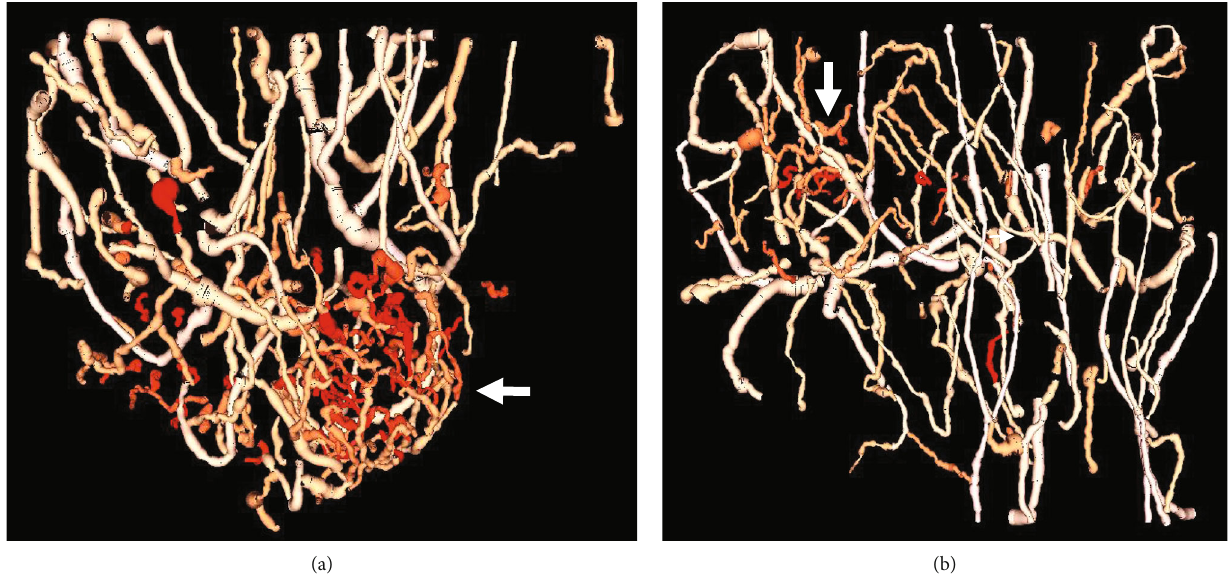
Figure 7: Renderings of segmented vasculature of tumors with color intensity showing tortuosity (SOAM). (a) shows a large tumor (5.1 mm) and (b) shows a smaller tumor (3.5 mm) with a cluster of tortuous vessels in the tumor region indicated by an